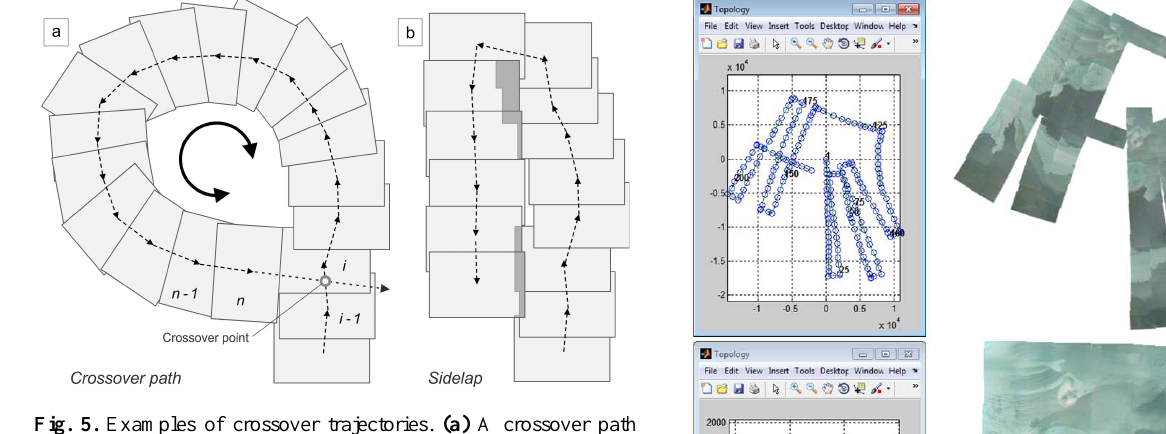
Fig. 5. Examples of crossover trajectories. (a) A crossover path is a trajectory, in which the camera crosses its own trajectory and surveys a same point several times; adapted from Fleischer et al. (1996). (b) Side-overlap, or sidelap, occurs when parallel lines of mosaic overlap (dark grey areas); in this case, the camera trajectory does not necessarily cross itself.